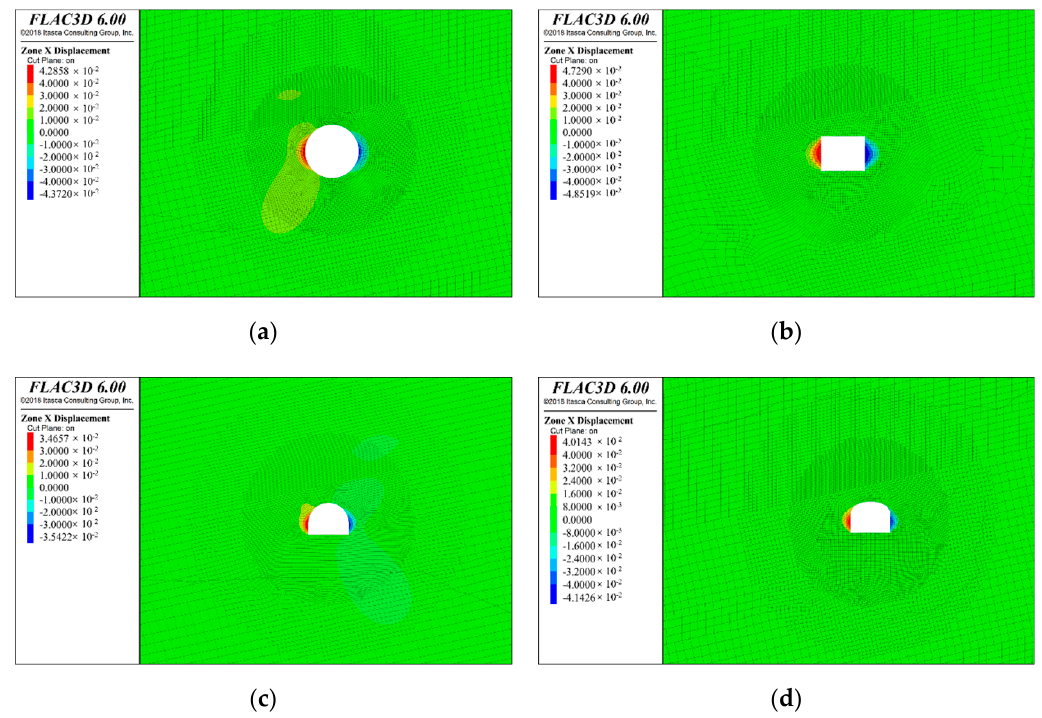
Figure 6. Influence of section shape on the horizontal displacement cloud map of surrounding rock of a bottom drainage roadway. ( a ) Circular section; ( b ) Rectangular section; ( c ) Semicircular arch section; ( d ) Three-center arch